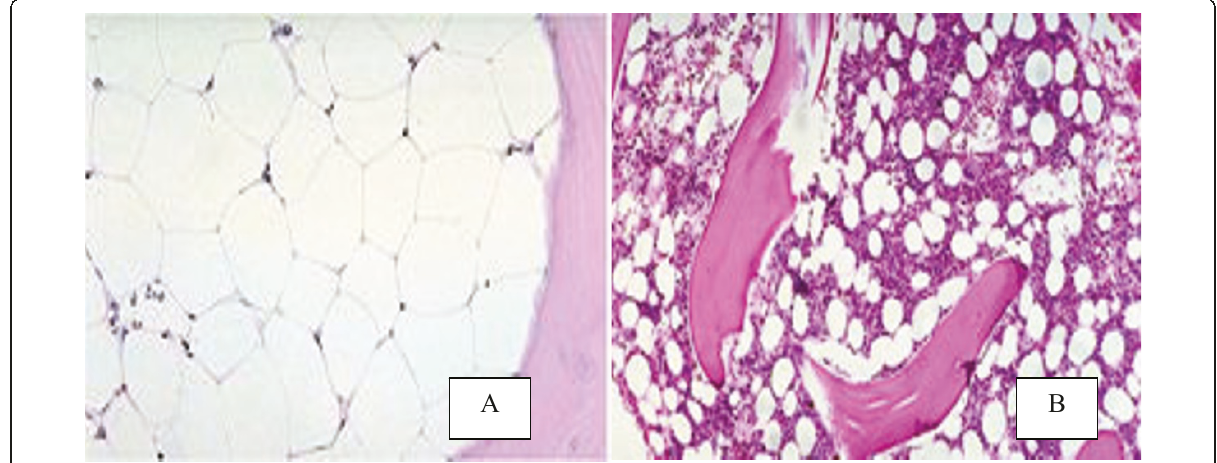
Figure 1 BMB sections by (H & E staining) : (A) Severe hypoblastic marrow: marked increase in fat space more than 80%. (B) Mild hypoblastic marrow: Just increase in fat space slight over 50%.